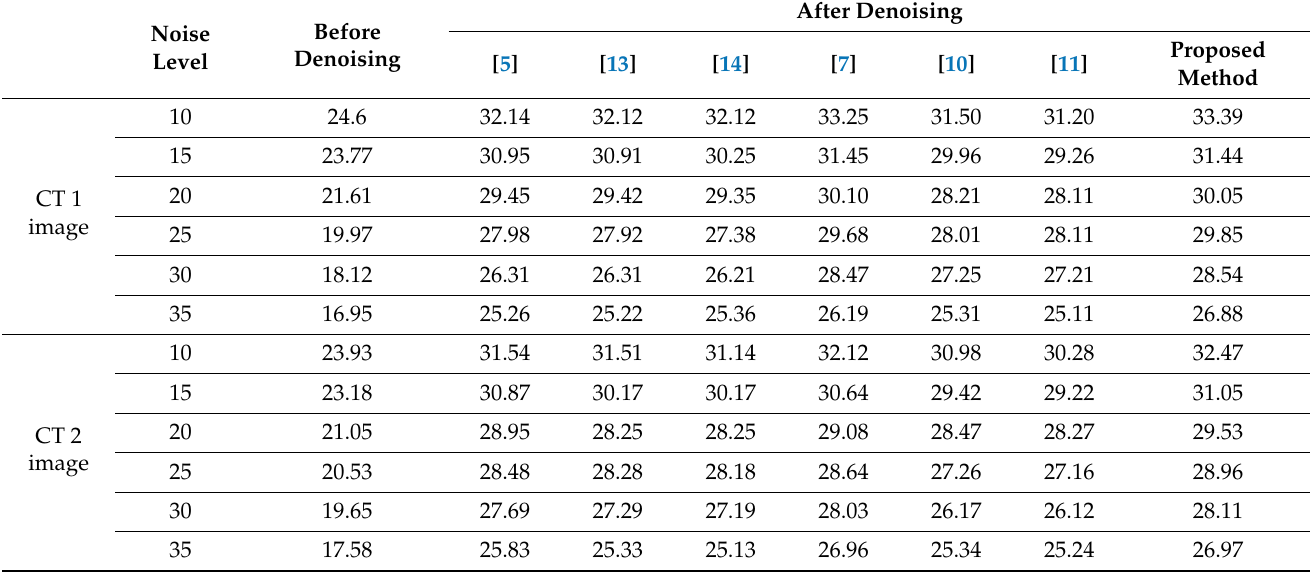
Table 2. PSNR of denoised